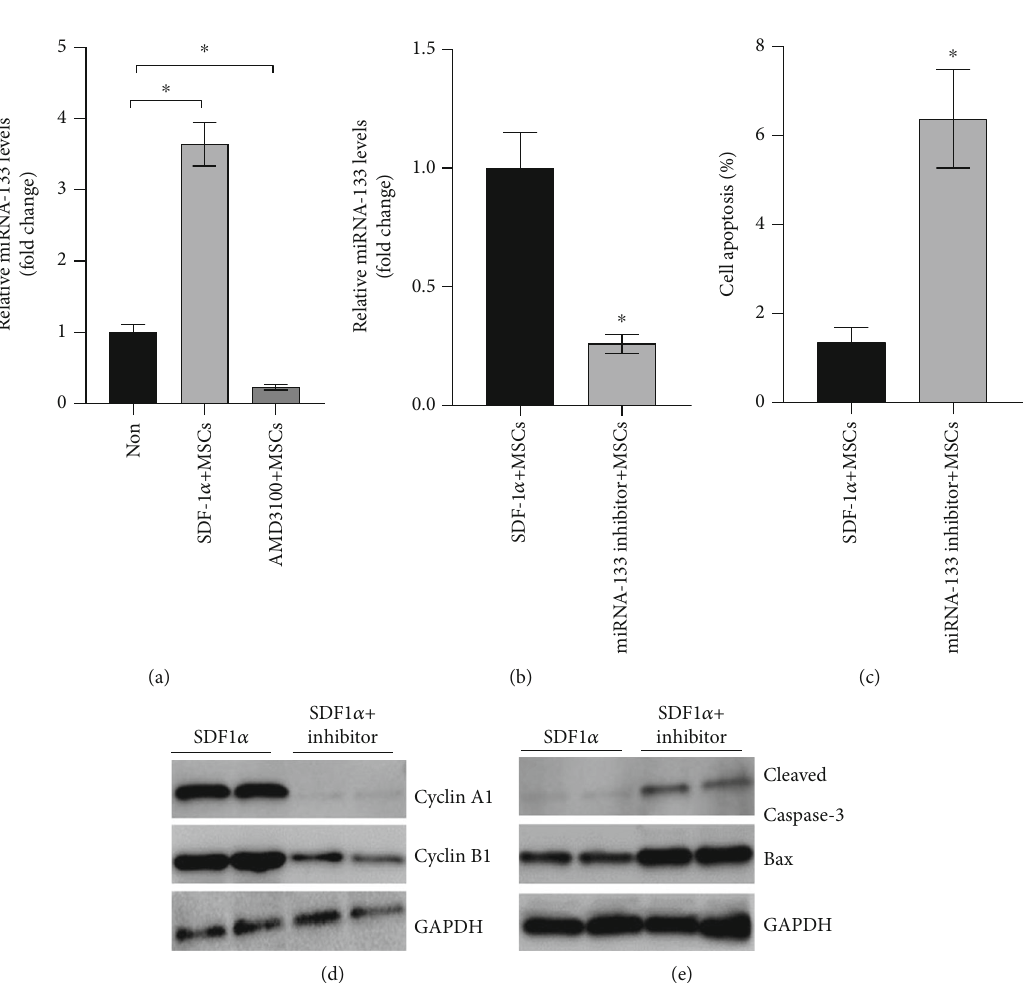
Figure 4: SDF-1 α regulates the survival of MSCs on B cells through miR-133. (a) The expression of miR-133 in MSC was increased in the presence of 0.1 μ g/mL SDF-1 α but was inhibited after treating with the AMD3100. (b) The e ff ects of miR-133 inhibitor on the expression of miR-133 in MSCs. (c) Transfected with the miR-133 inhibitor, the apoptotic rate of MSCs increased signi fi cantly. (d, e) miR-133 inhibitor in fl uences the expression of cyclin A1, cyclin B1, cleaved caspase-3, Bax, and in MSCs. ∗ P < 0 : 05